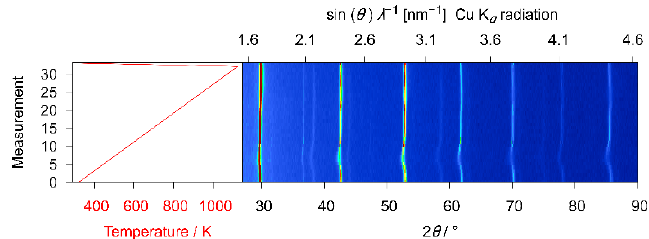
Figure 1. In situ X-ray diffraction patterns of Ba 2 In 1.8 Cr 0.2 O 5.3 (H 2 O) x (first batch) while heating under nitrogen flow of 20 sccm ( p = 0.15 MPa, p (O 2 ) < 5 ppm, p (H 2 O) < 5 ppm) in an XRK reaction chamber; for clarity reasons only 27° ≤ 2 θ ≤ 90° is shown.